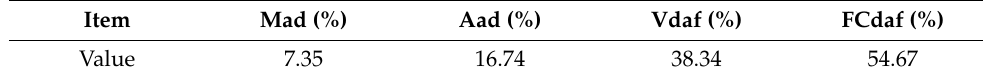
Table 1. The industrial analysis of the LRC sample.